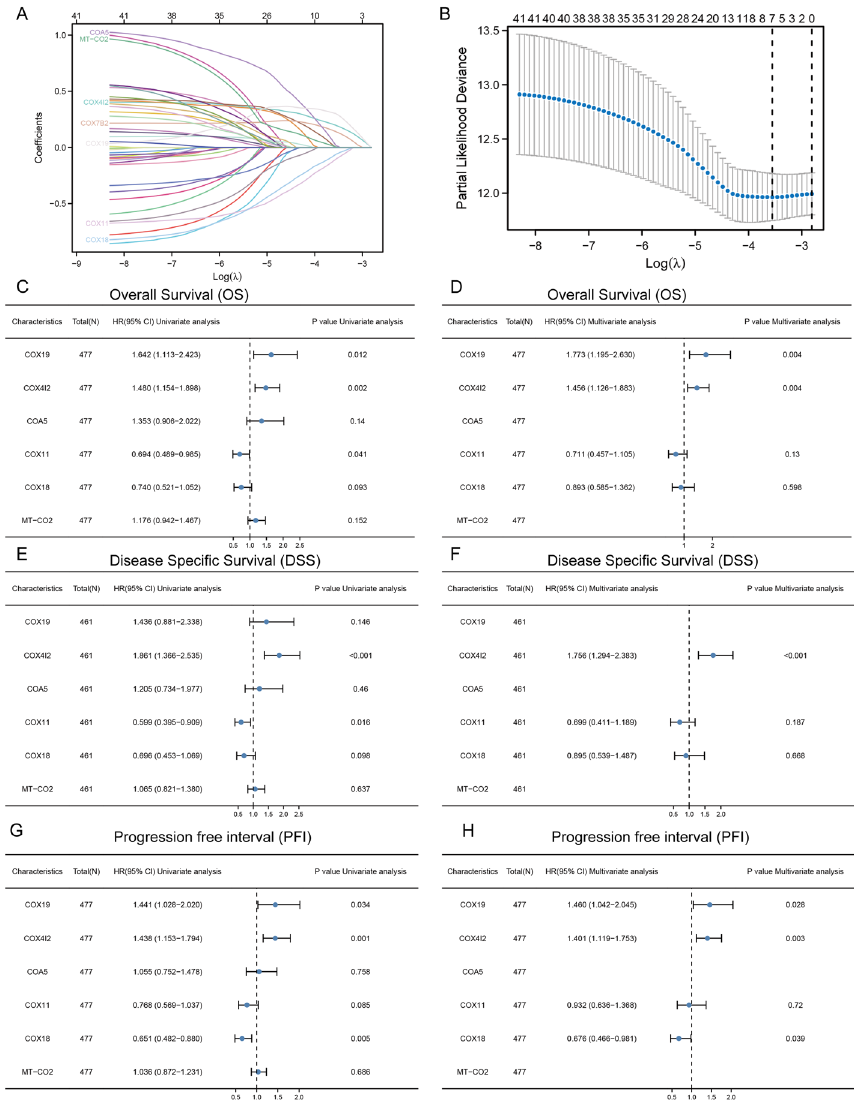
(PPI) network for COX4I2 is shown in Fig. 3e. GO and KEGG analyses indicated the involvement of COX4I2 in angiogenesis and stromal remodeling (Fig. 3f, g). The key subnetwork (Fig. 3h) obtained by the molecular complex detection (MCODE) plug-in showed a stronge association with angiogenesis (Fig. 3i). GSEA was then applied to